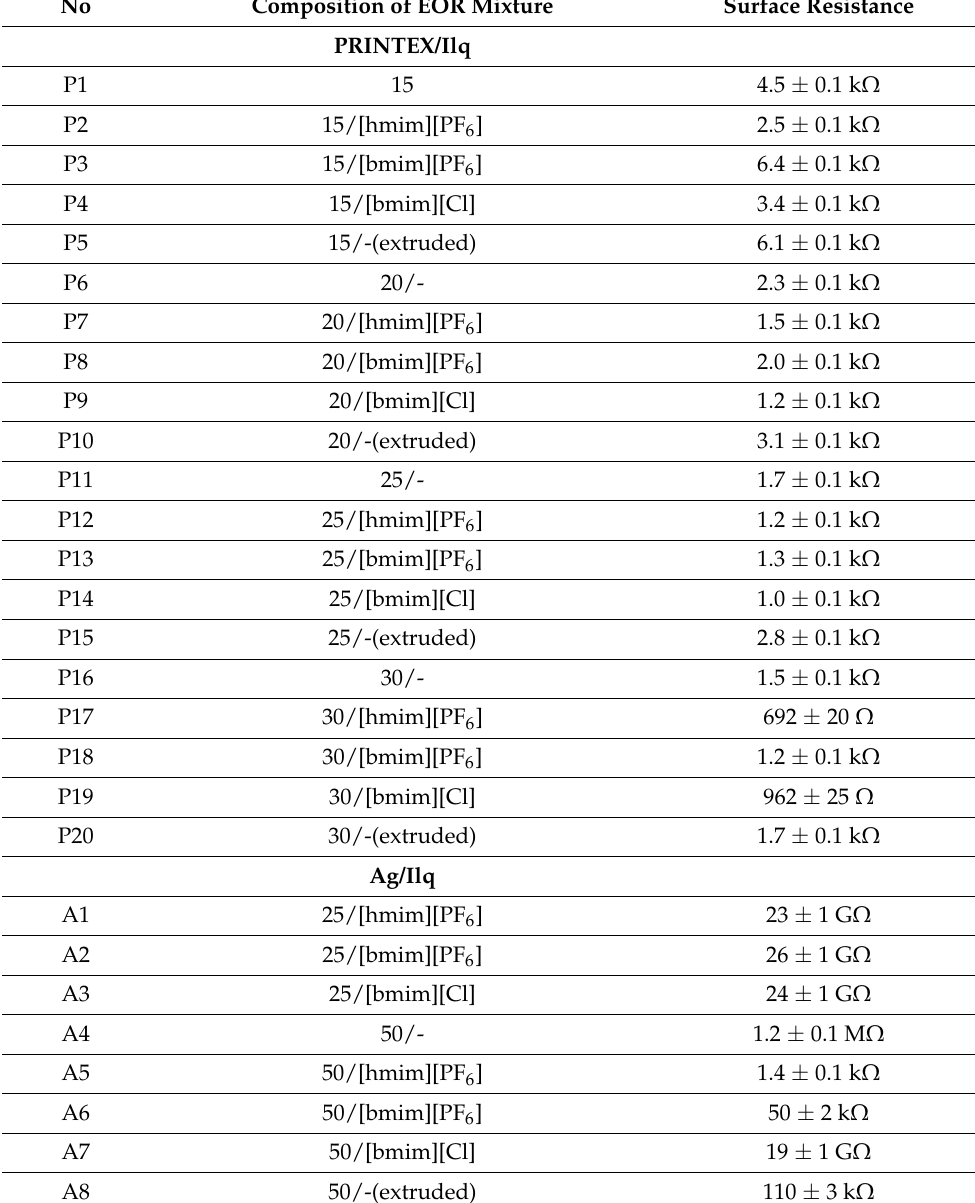
Table 3. The results of measurements of the surface resistance of EOR/PRINTEX/Ilq and